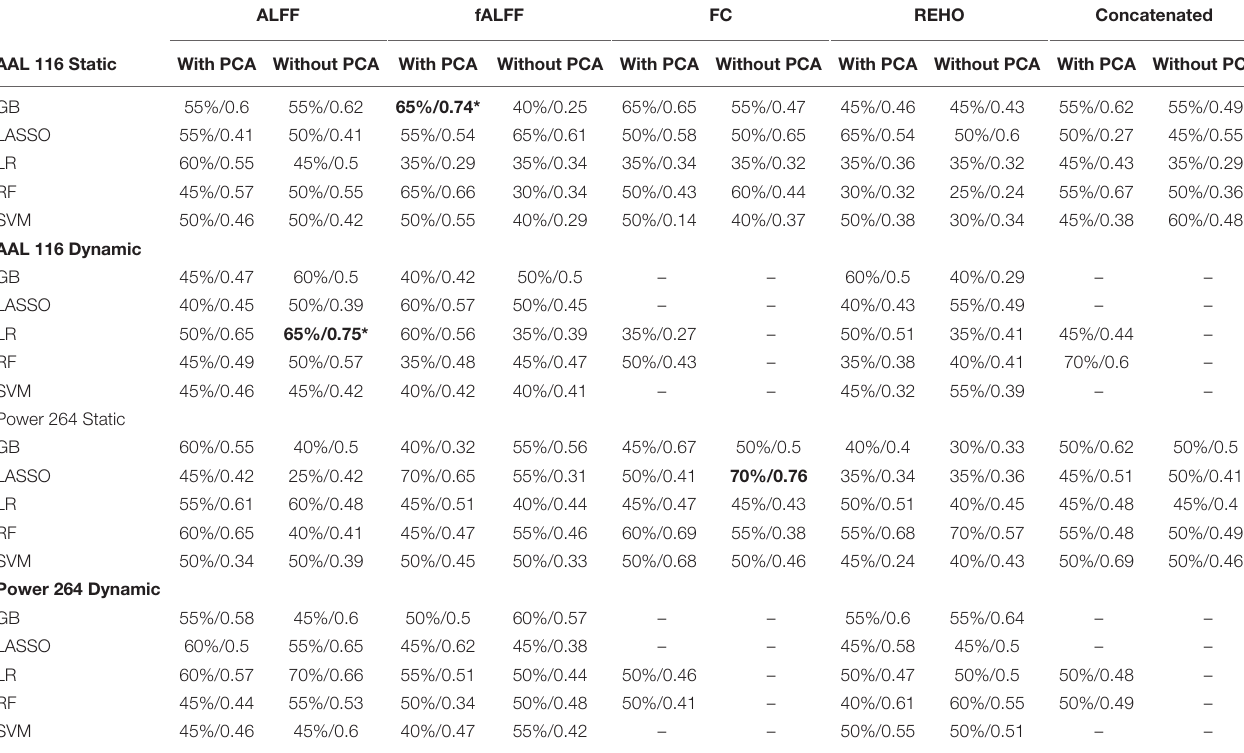
TABLE 4 | The accuracies and AUROCs of five ML algorithms for each static and dynamic rsfMRI measures, divided into two atlases. ALFF fALFF FC REHO